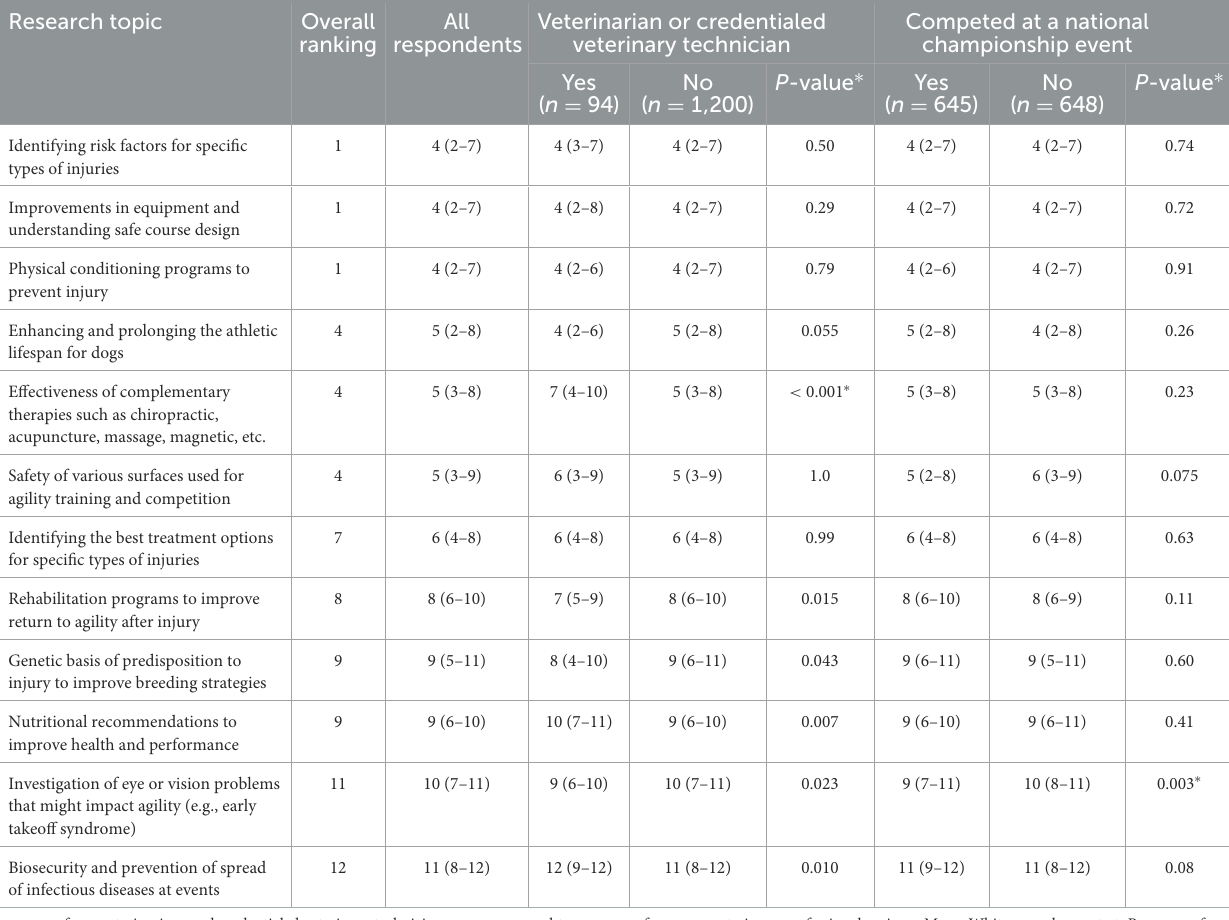
TABLE 7 Median (IQR) priority rankings for each research topic as provided by all respondents or by specified subsets of respondents.